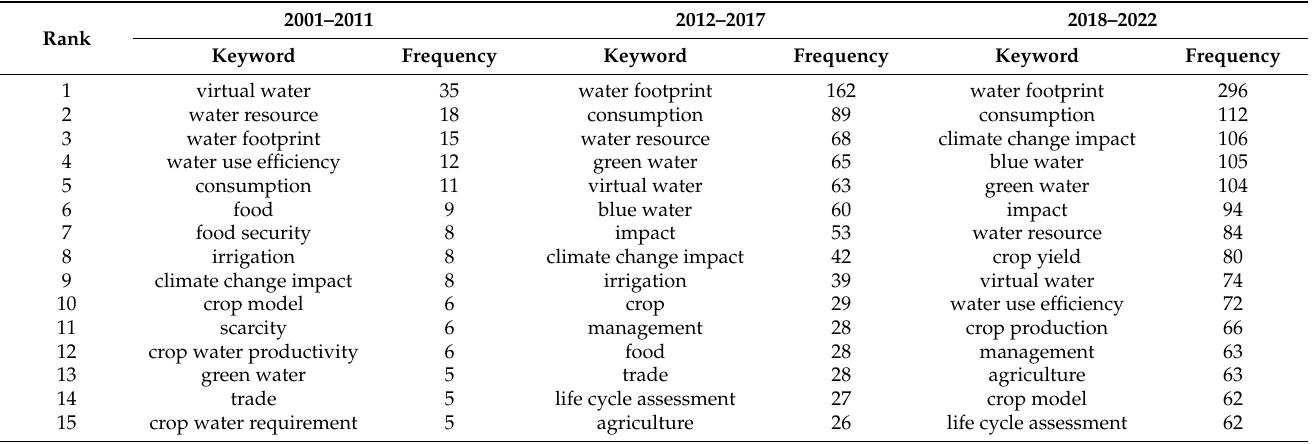
Table A1. Top-15 high-frequency keywords 2001–2022.